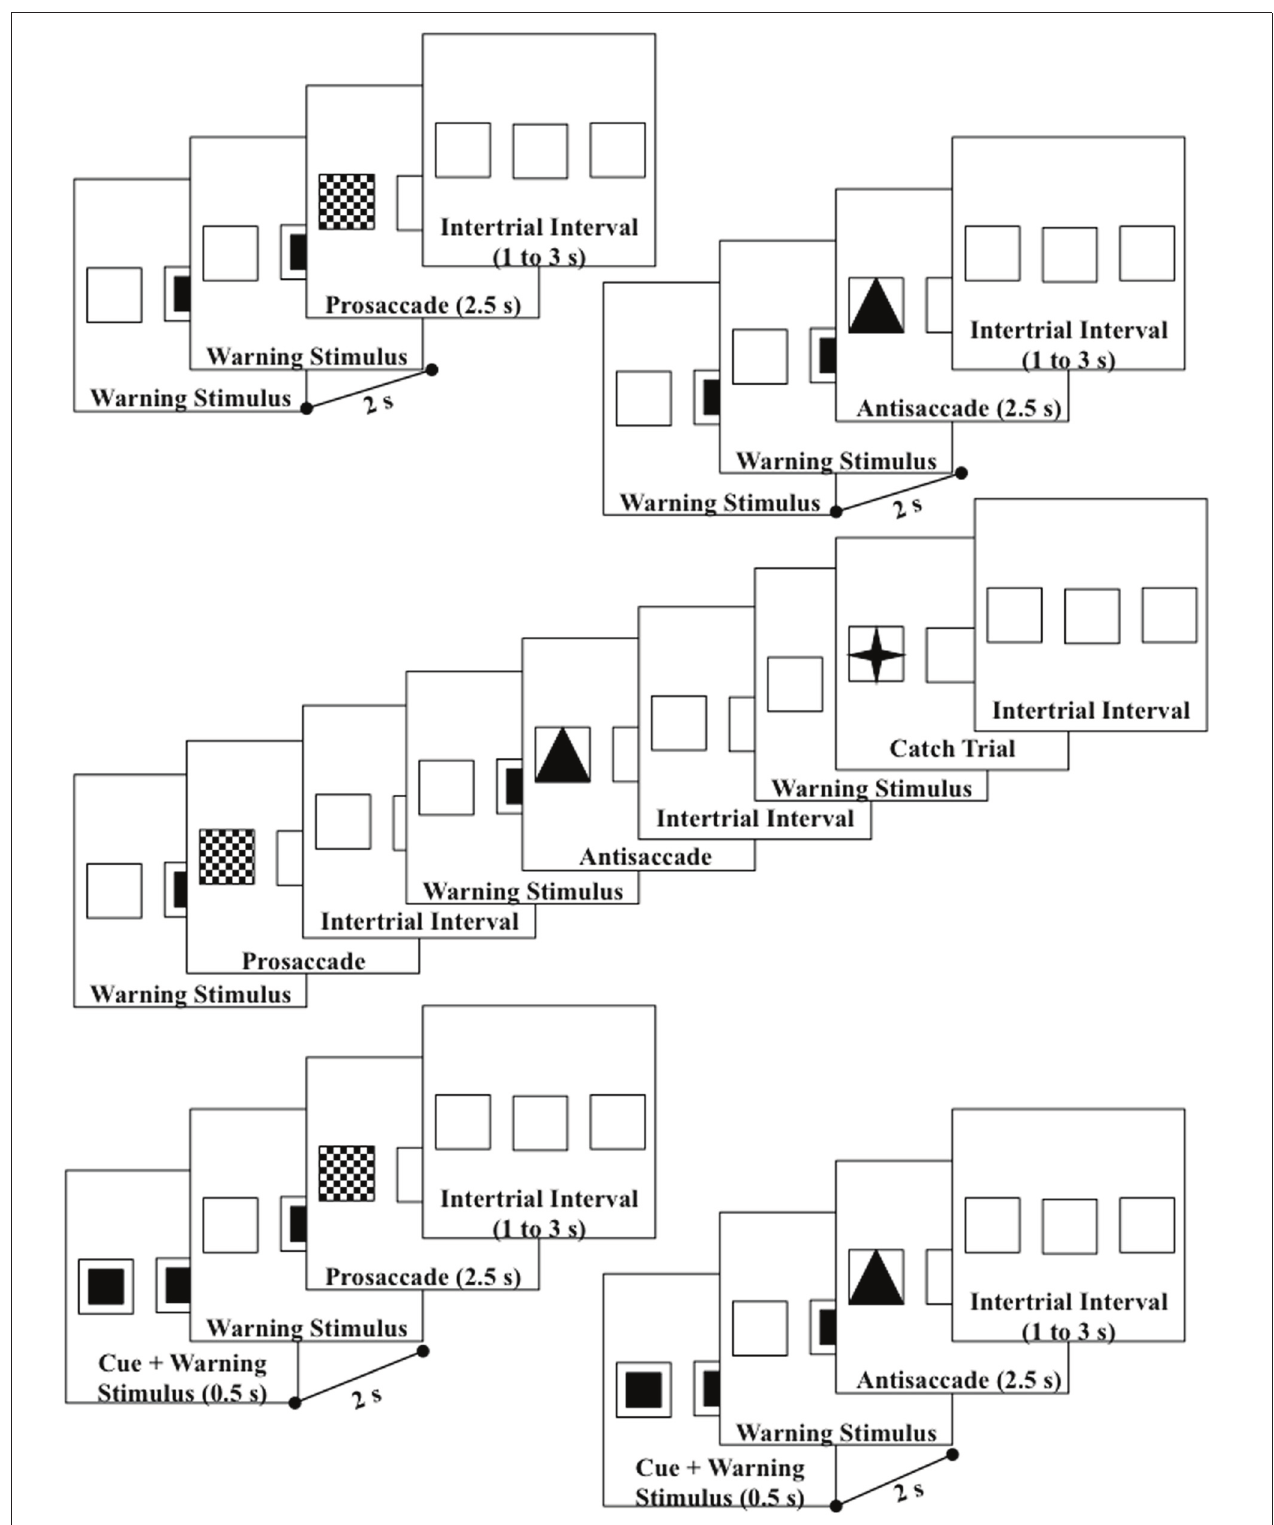
FIGURE 1 | Design of the trials—upper diagrams are uncued prosaccade and uncued antisaccade trials; middle diagram shows the uncued block presentations; lower diagrams are cued prosaccade and cued